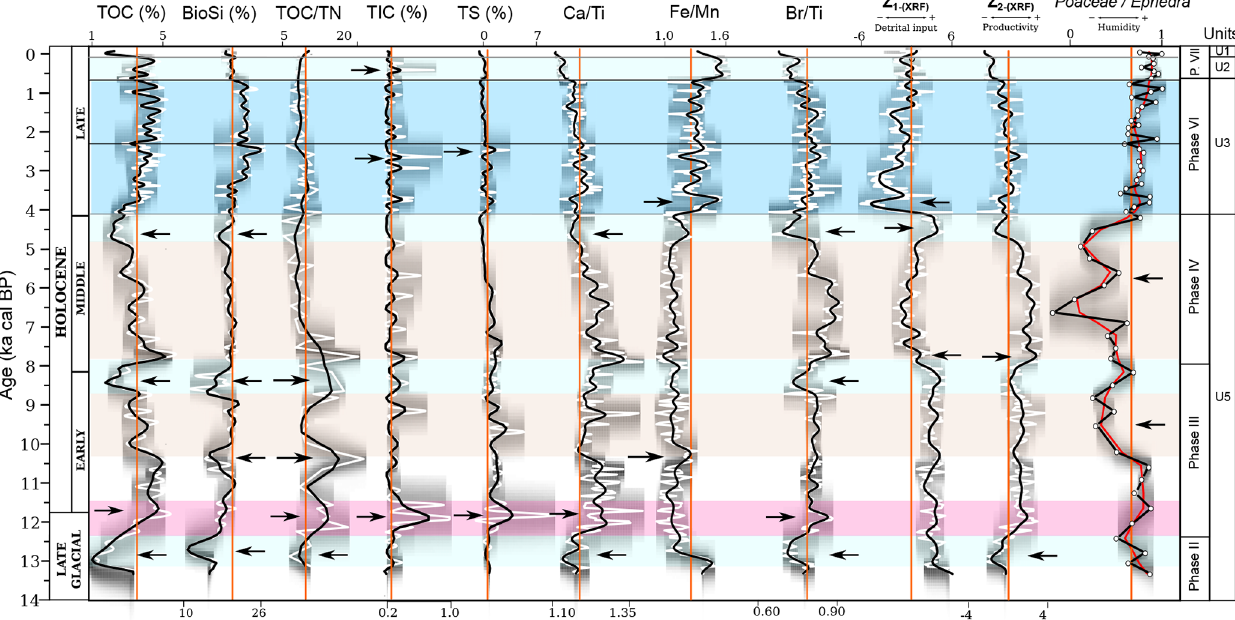
Figure 7. Holocene paleoenvironmental evolution in the LdM sequence. Comparison of organic productivity, paleoredox, sediment delivery indicators ( Z 1 score) and Poaceae / Ephedra ratio plotted according to the posterior age–depth model (gray). Total organic carbon (TOC, %), opal (BioSi, %), total inorganic carbon (TIC, %), total sulfur (TS, %) and the XRF ratios in logarithm of carbonate (Ca / Ti) productivity, anoxic conditions (Fe / Mn), organic (Br / Ti and Z 2 score) productivity and sediment delivery indicators ( Z 1 score). Darker grays indicate more likely calendar ages (age model uncertainty); the white curve shows the single “best” model based on the weighted median age for each proxy; the solid black curve shows the fit for each time series using a smoothing polynomial spline; and orange lines are the average of each time series. The blue, light blue, red and light brown boxes indicate the timing of cold–humid, dry–cold, dry–warm and dry conditions recorded in the LdM,